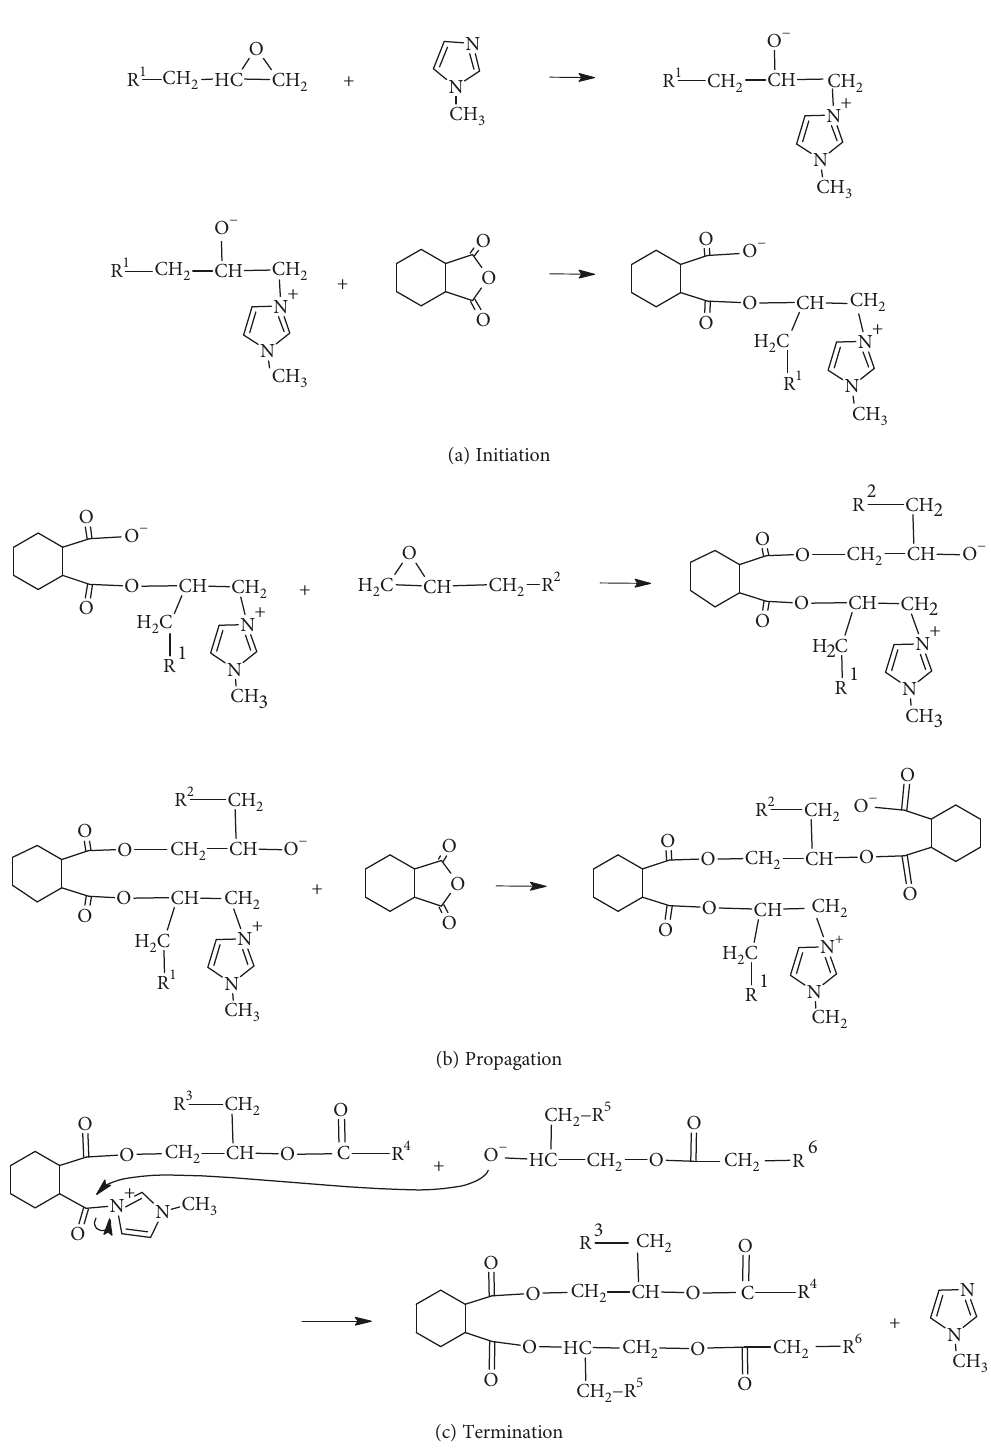
Figure 3: Reaction mechanism for the imidazole initiated epoxy-anhydride copolymerization, including a termination step